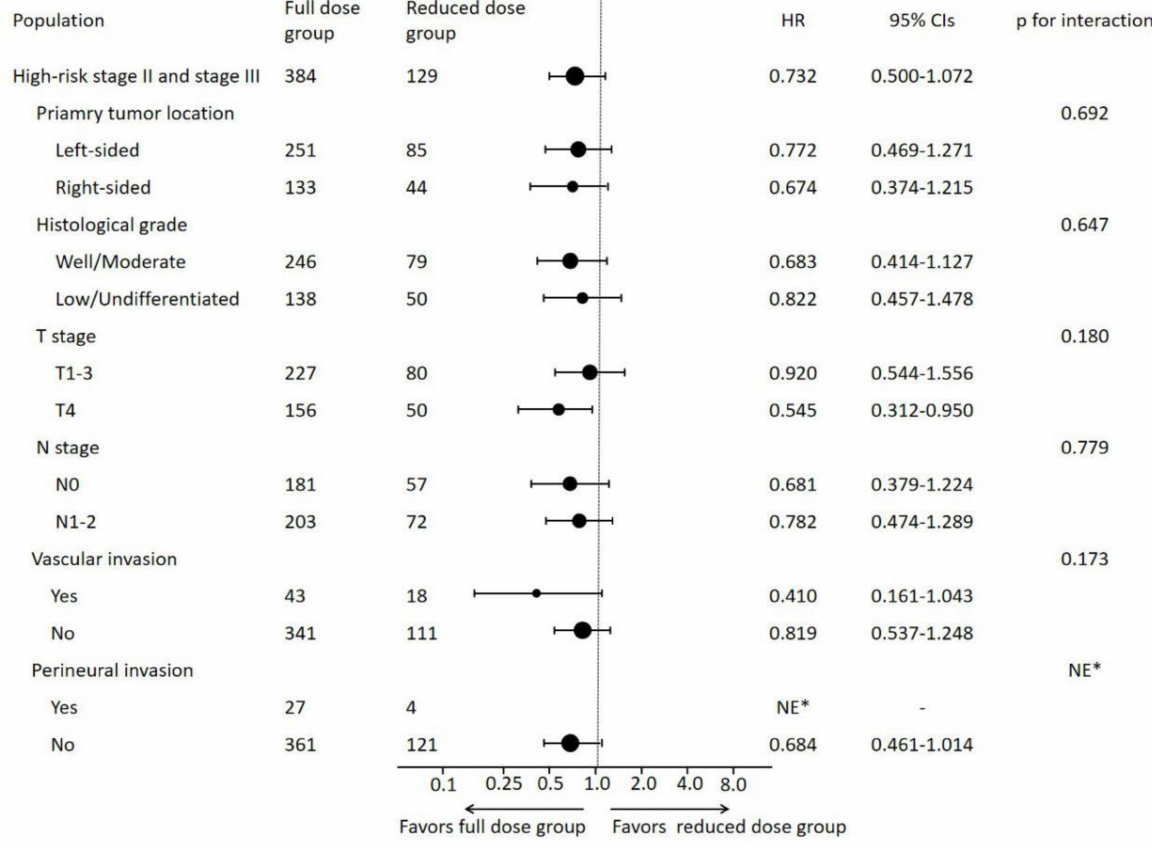
Figure 4. Forest plots of DFS stratified by adjuvant chemotherapy in high-risk stage II and stage III patients. Subgroups were divided according to traditional clinicopathological high-risk variables: HR, hazard ratio; CI, confidence interval, NE, not evaluable. * There were no DFS events in subgroup from reduced dose group with perineural